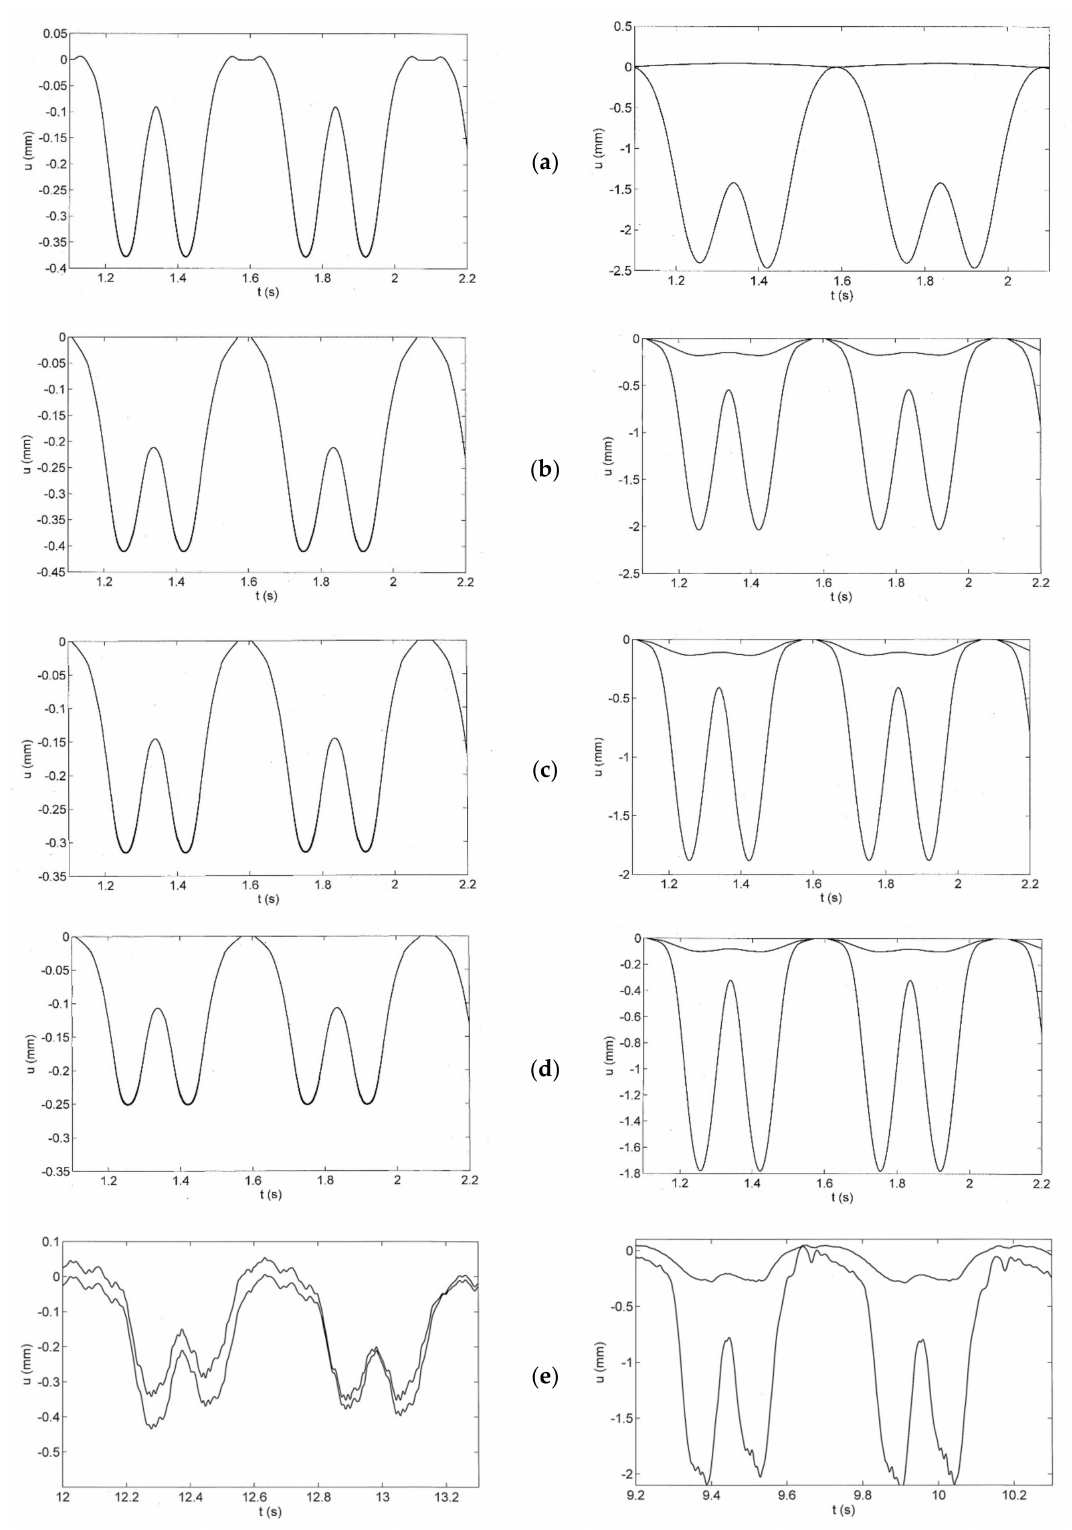
Figure 13. Calculated displacement for the track plate and base layer under the passage of four bogies: ( a ) FEM model; FEBEM models with v S = ( b ) 150, ( c ) 175, ( d ) 200 m/s, and ( e ) measurements, intact slab track (left, track plate and base layer have identical displacements) and damaged slab track (gap of L D = 5.85